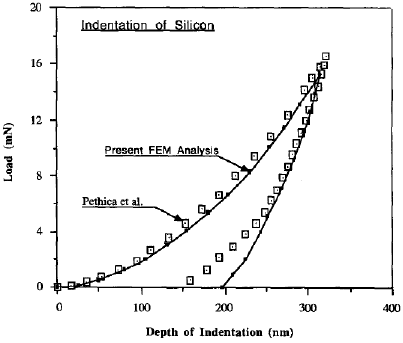
Figure 30. Comparison between the results from the present FEM analysis and those from Pethica et al. [106] on indentation of silicon [104].